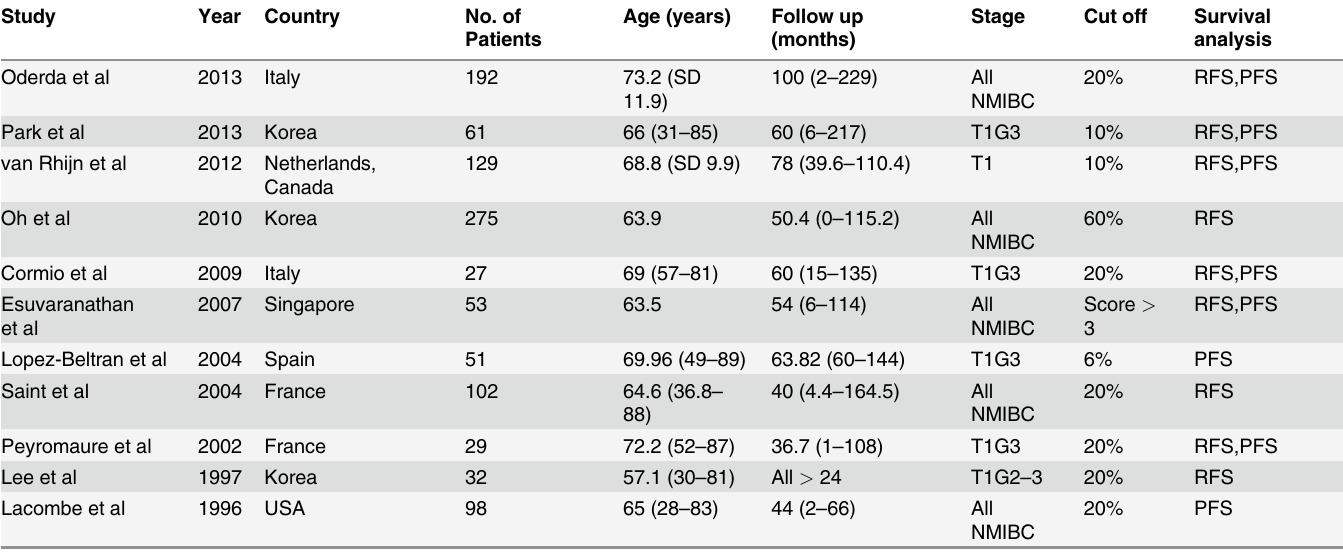
Table 1. Main characteristics of all studies included in this